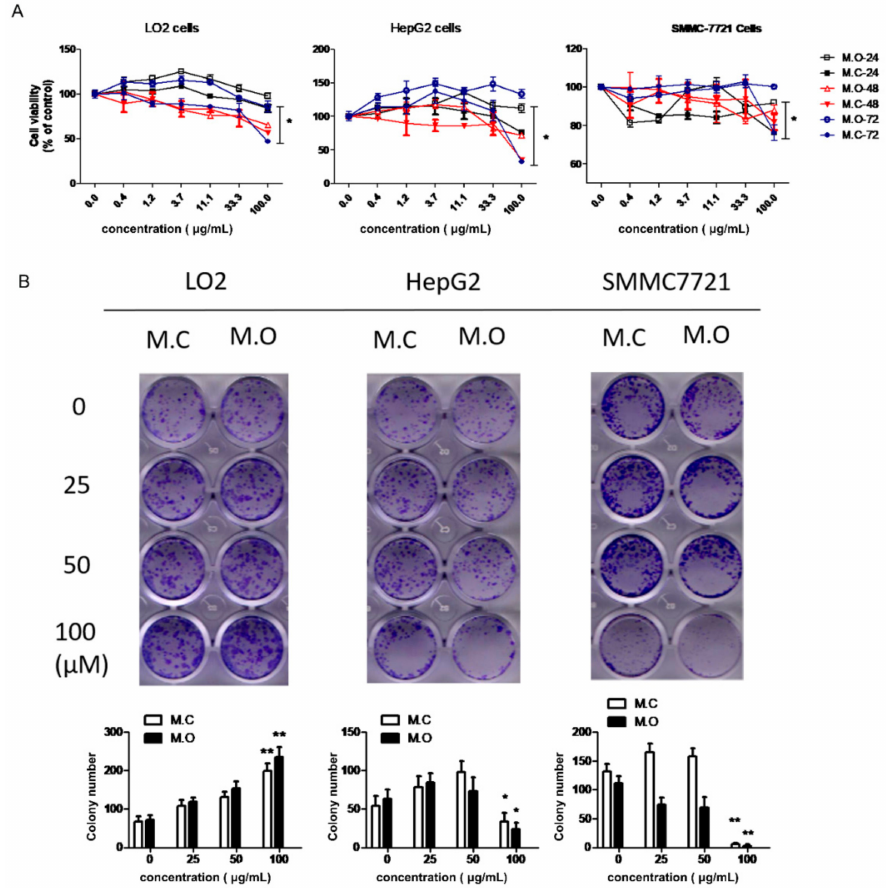
Figure 6. The e ff ect of M. o ffi cinalis and M. citrifolia root extracts on cell growth. ( A ) Cell viability was